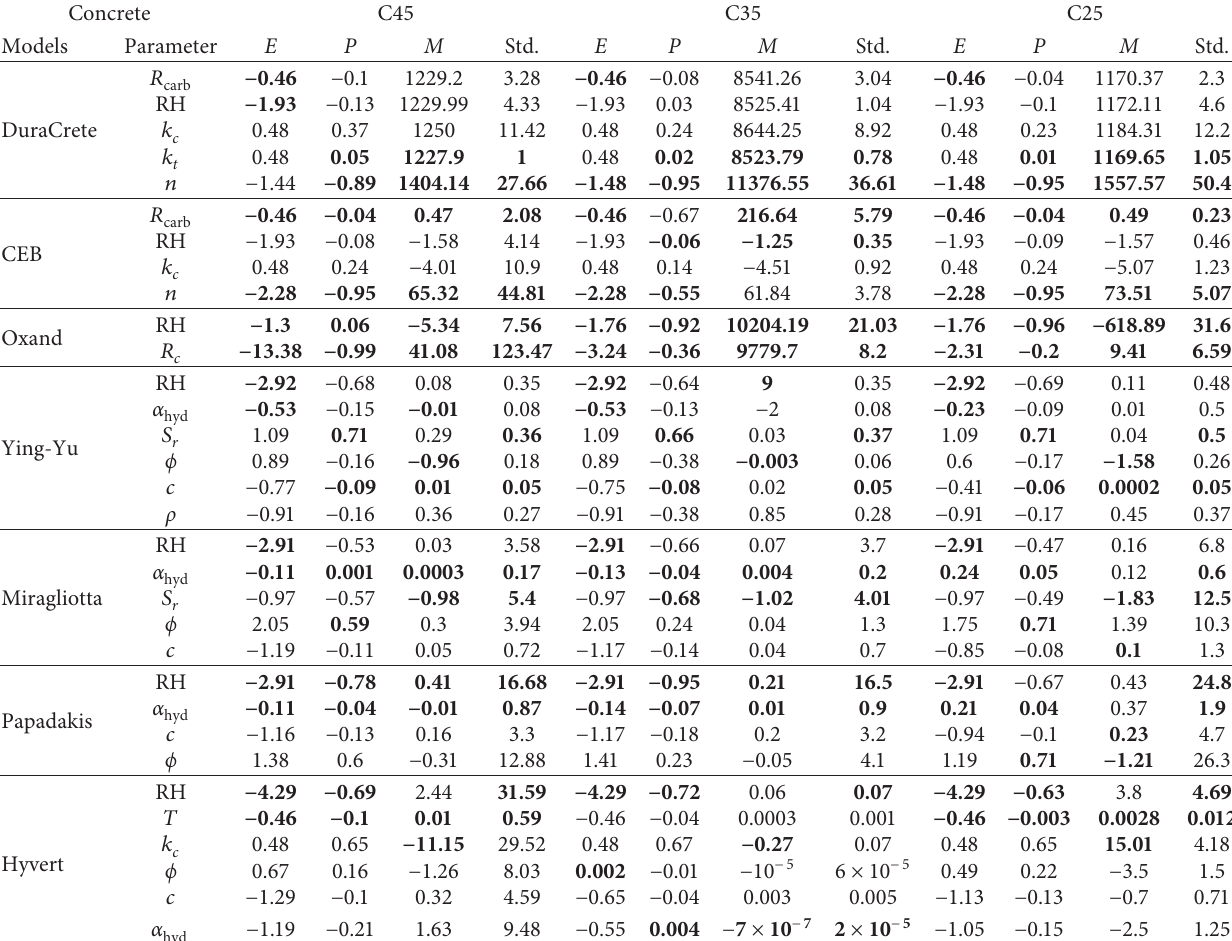
Table 11: Summary of the results of sensitivity analysis for all concrete carbonation models at 50 years